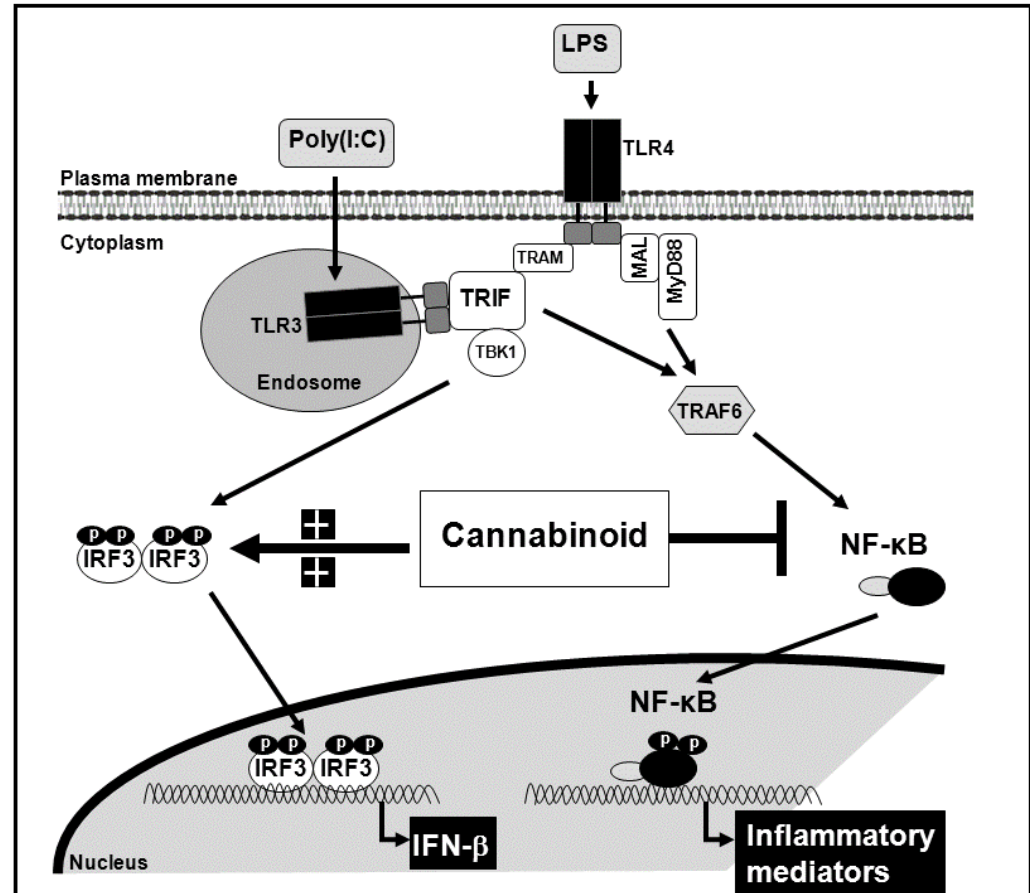
FIGURE 1. Mechanism of R (+)WIN55,212-2-induced regulation of TLR3 and TLR4 signaling[68]. R (+)WIN55,212-2 inhibits the proinflammatory signaling axis triggered by TLR3 and TLR4, while selectively augmenting TLR3-induced expression of IFN-  . Innate immune recognition by TLRs culminates in the induction of an array of immune response genes, including proinflammatory cytokines and chemokines, in addition to type-I IFNs. TLRs induce signaling via recruitment of the adaptor MyD88, with the exception of TLR3, which induces Myd88-independent signaling via TRIF protein. TRIF-mediated signaling promotes the phosphorylation and nuclear localization of transcription factor IRF3 and subsequent induction of type-I IFNs. TLR4 uses Myd88-dependent and -independent pathways to activate NF-  B via the downstream adaptor tumor necrosis factor (TNF) receptor-associated factor 6 (TRAF-6), resulting in the translocation of an active heterodimer protein to the nucleus and induction of proinflammatory